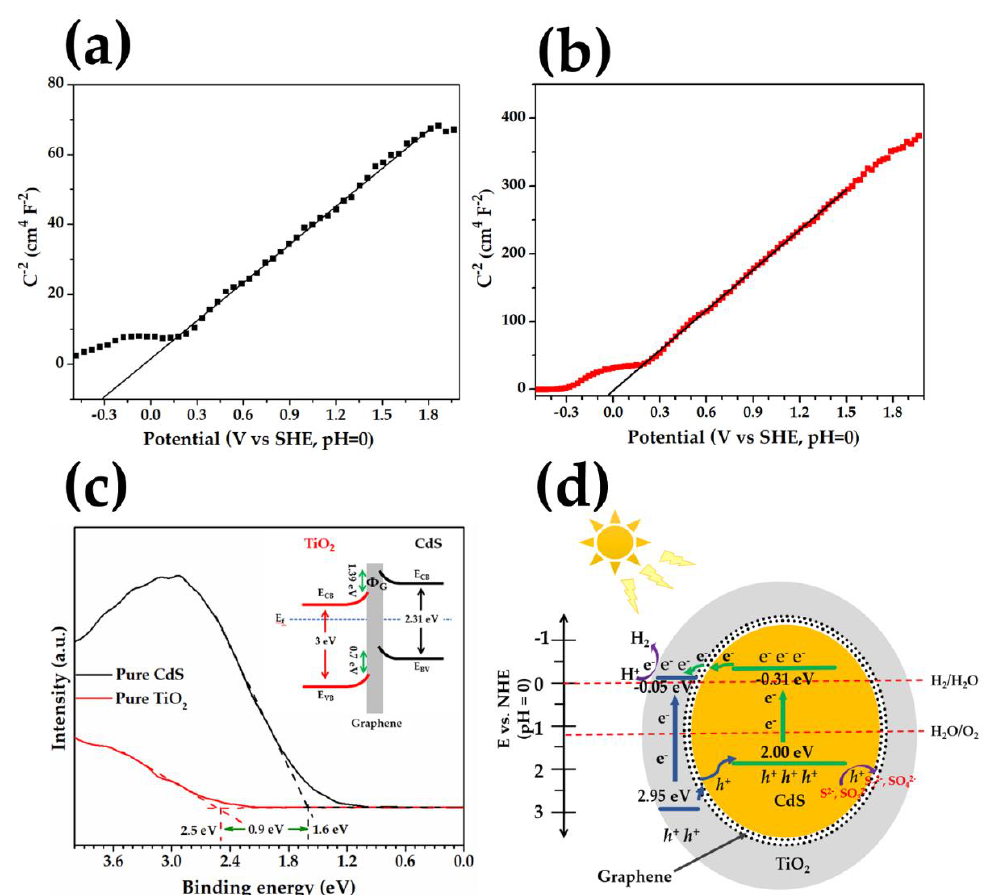
Figure 7. Mott–Schottky plots of pure CdS ( a ), pure TiO 2 ( b ), valence band XPS along with band diagram of CdS@xG@TiO 2 ( c ) and schematic photocatalytic reaction mechanism ( d ).